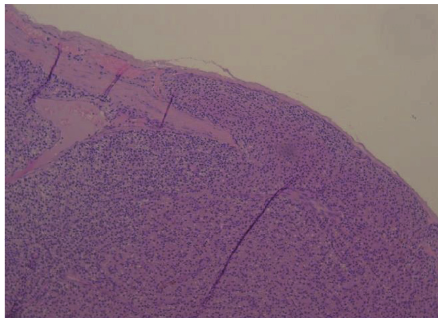
Figure 2: Section of the right inferior parathyroid specimen demonstrating a venous vascular invasion focus (H&E, 10x).